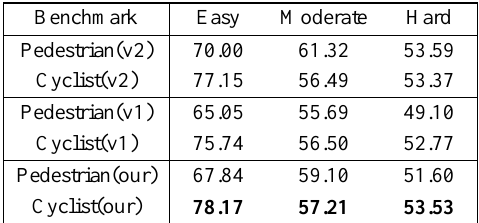
Table 1. Performance on KITTI val set for pedestrians and